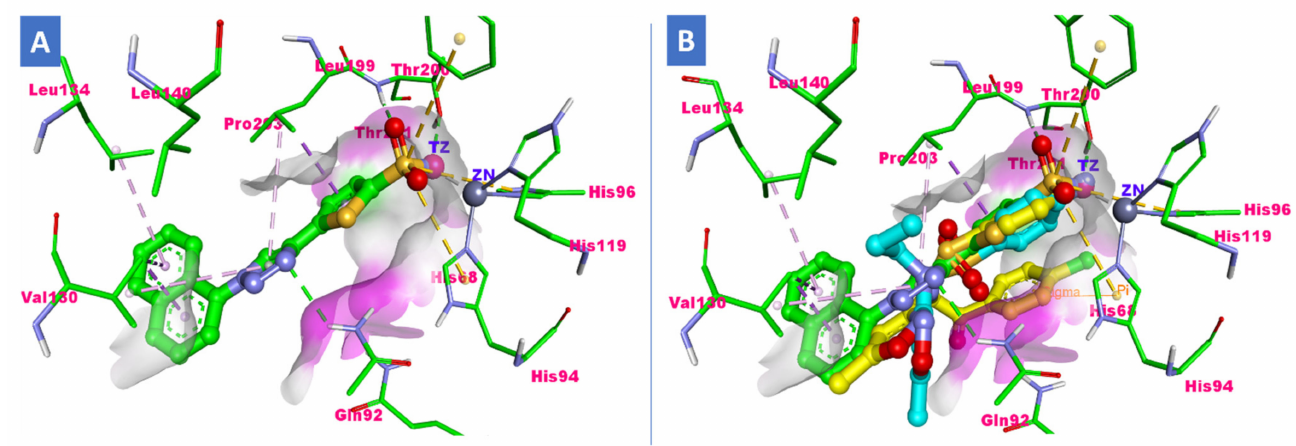
Figure 9. ( A ) 3D binding pattern of 9fk (green) into active place of hCA-IX isoenzyme; ( B ) Overlay of S3 , S15 and 9FK to show the shape complementarities with hCA-IX active place and the difference in torsions and conformations. The docked and redocked poses were displayed in ball & stick style. Zn atom was shown as a blue ball while pseudoatom TZ was represented as a pink ball. Favorable co-ordinate bond with Zn cation, hydrogen bonds and π -Stacking were showed in dashed blue, green and orange dashed lines, respectively. Hydrogen bond surfaces around docked poses were created. Hydrogen atoms were omitted for clarity